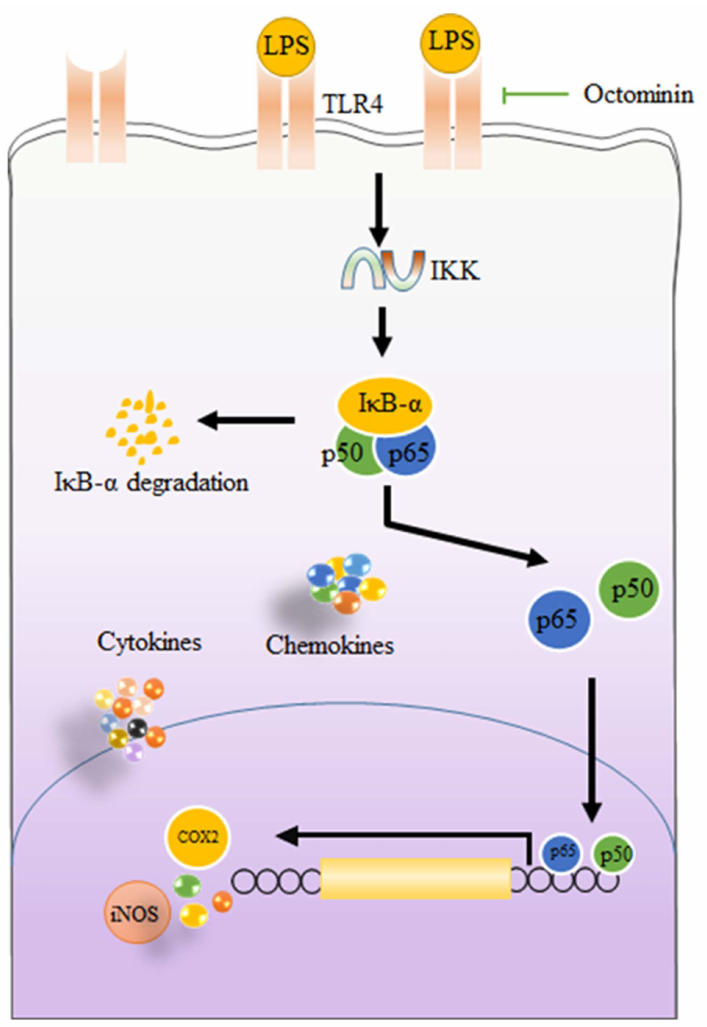
Figure 7. Graphical illustration of possible mechanisms of Octominin to inhibit LPS-activated inflammatory responses in RAW 264.7